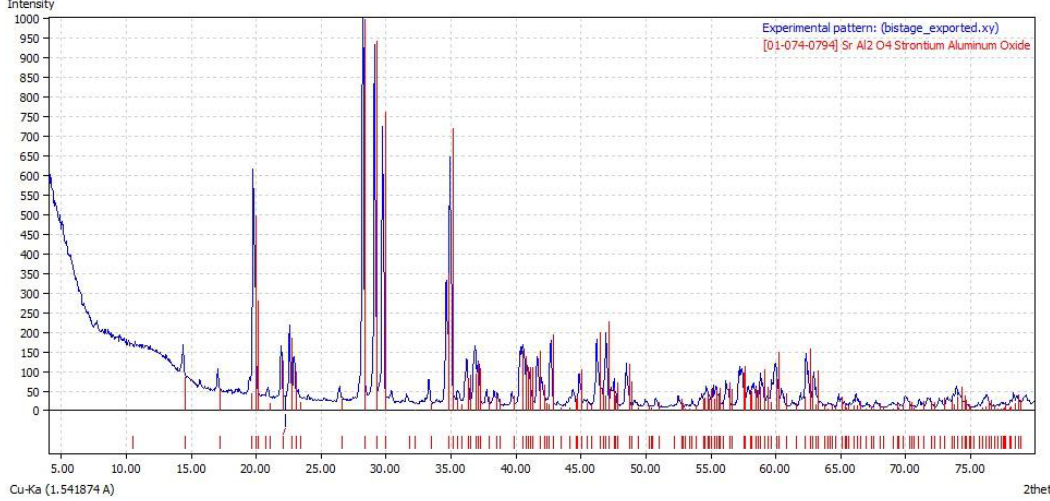
Figure 3. XRD patterns of SAPN ( top ) and its standard spectrum ( bottom ).